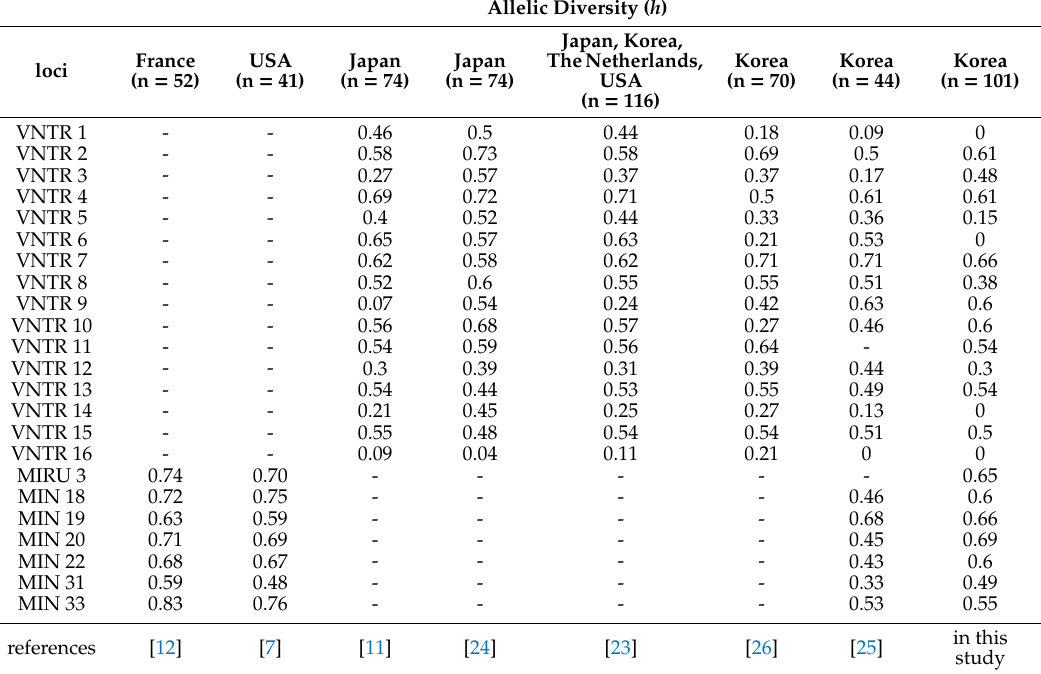
Table 2. Allelic diversity of variable number tandem repeat (VNTR) and VNTR-mycobacterial interspersed repetitive units (MIRU) for strains used in previous studies and in this